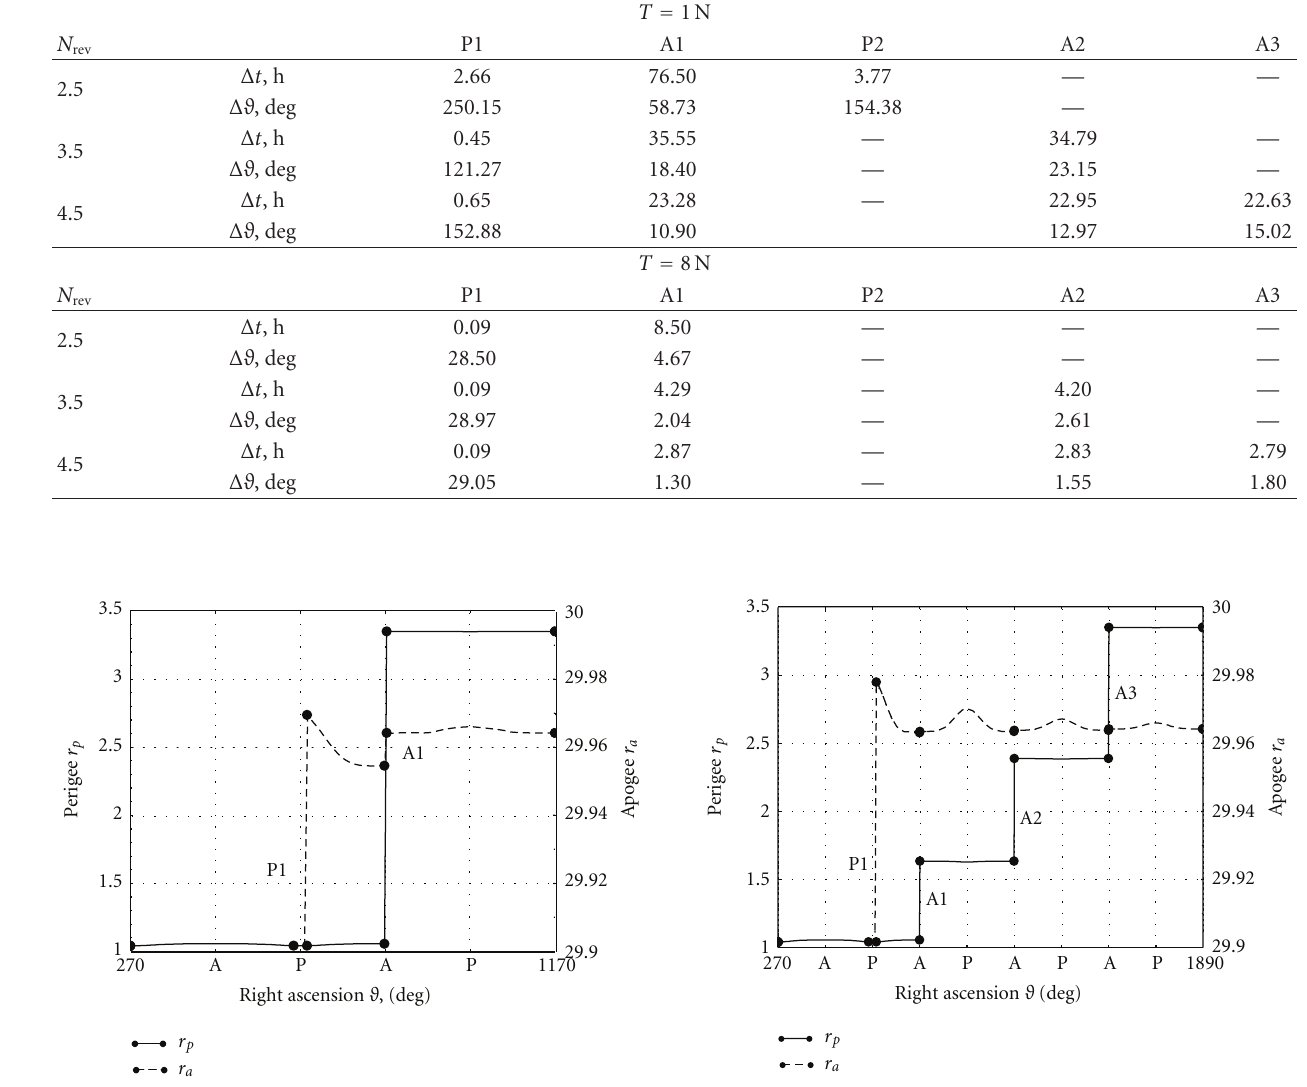
Figure 4: Perigee and apogee evolution for the 2.5-revolution 8N transfer (J2 only).